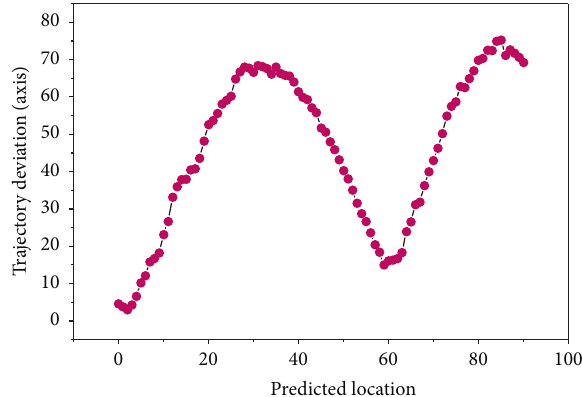
Figure 13: MAE scatter plot for straight trajectory prediction.